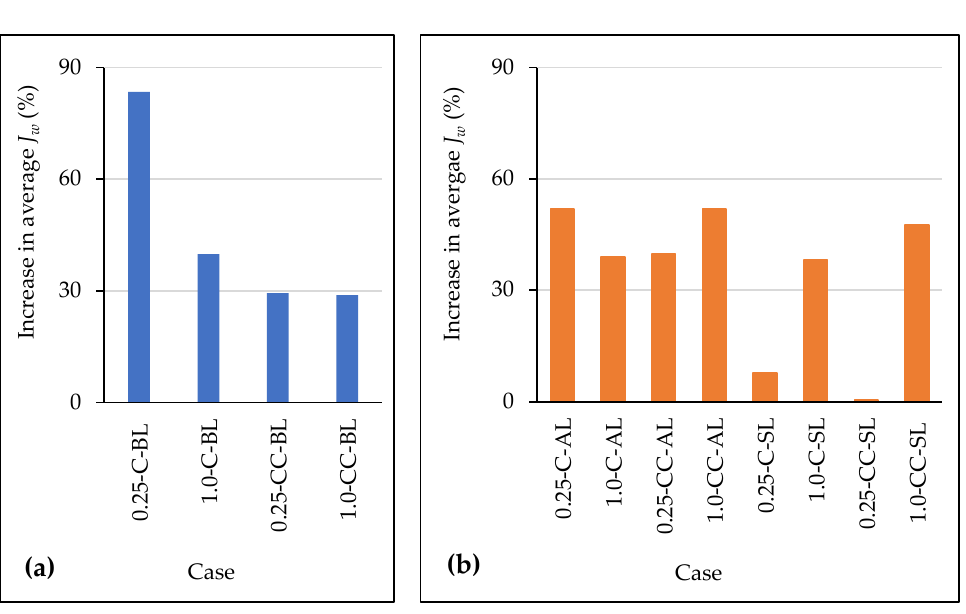
Figure 7. Increase in average J w using NaCl compared to MgCl 2 draw solution ( a ) without the use of ultrasound and ( b ) with the use of ultrasound.